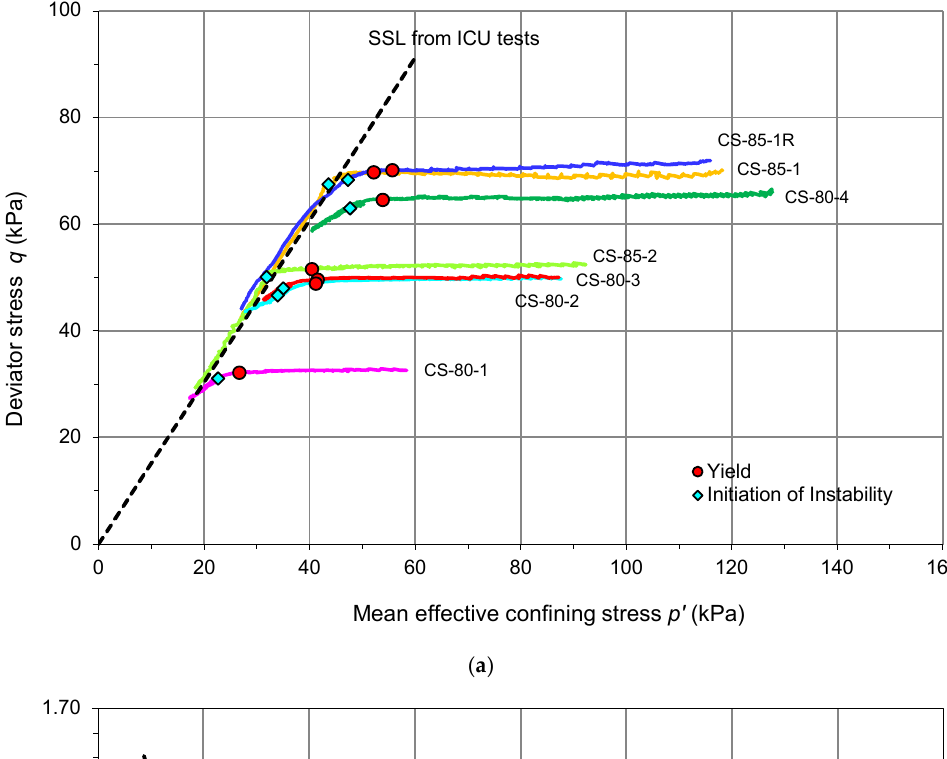
, where is the mean effective confining stress at the steady-state line at the current specific volume. Note that different